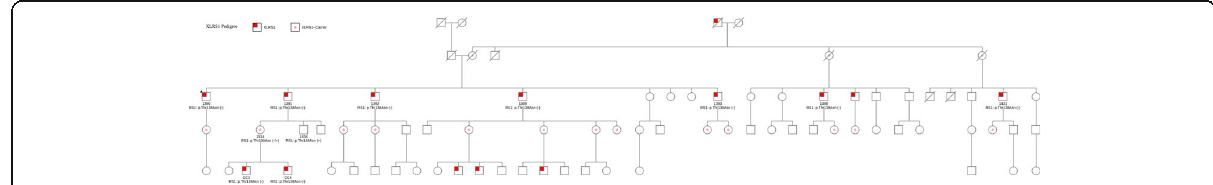
Fig. 1 Pedigree of 5 generations of an XLRS1 pedigree. Individuals marked with a red square were confirmed to be clinically affected. RS1 genotype has been annotated within the pedigree tree for those